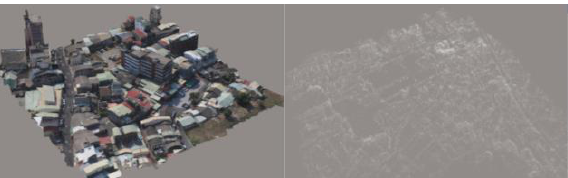
Figure 18 Three-dimensional model and point cloud